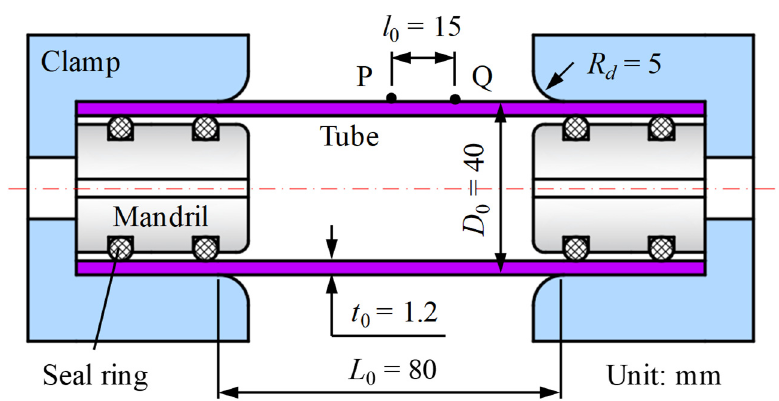
Figure 4. Schematic diagram of the tube specimen.